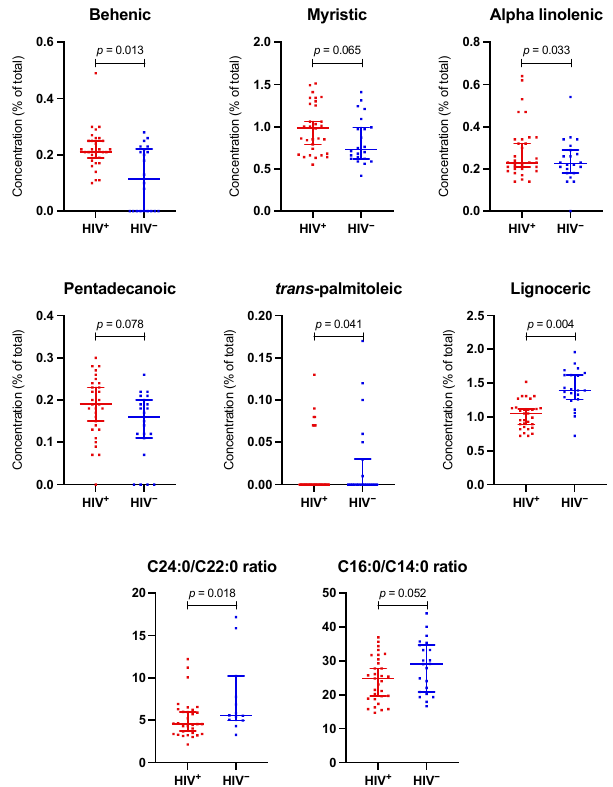
Figure 3. Main differences in plasma fatty acids and estimated activity of ELOVL1 and ELOVL6 elongases, according to HIV status. The dot plots show the most significant differences between the two groups regarding fatty acids plasma concentrations and calculated ratios. C24:0/C22:0 and C16:0/C14:0 ratios estimate the activity of ELOVL1 and ELOVL6 elongases, respectively. The p -value is obtained from the adjusted linear regression model.